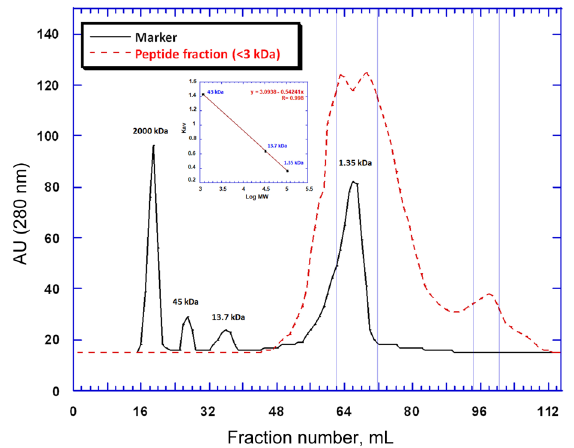
Fig. 4. Gel filtration chromatogram of partially purified peptide fraction using Sephacryl S-100